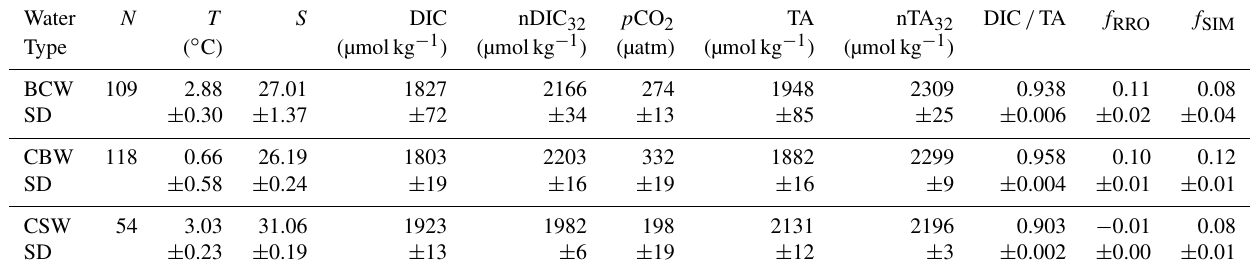
Table 1. Summary of three water types (BCW, Barrow coastal water; CBW, Canada Basin water; and CSW, Chukchi Sea water) at the surface in the western Arctic Ocean. All samples were pumped up underway from an intake at ship’s bottom. Values are averages for samples collected from 4 to 11 September 2013. N denotes the number of samples. nDIC 32 and nTA 32 are DIC and TA normalized to S =